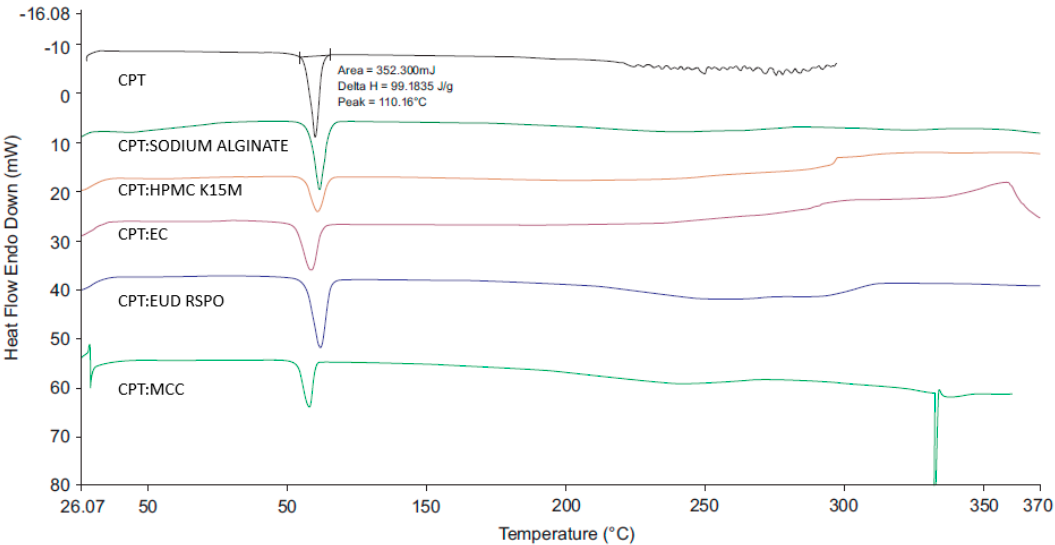
Figure 9. DSC thermogram for CPT and 1:1 w / w mixtures of CPT and potential excipients.